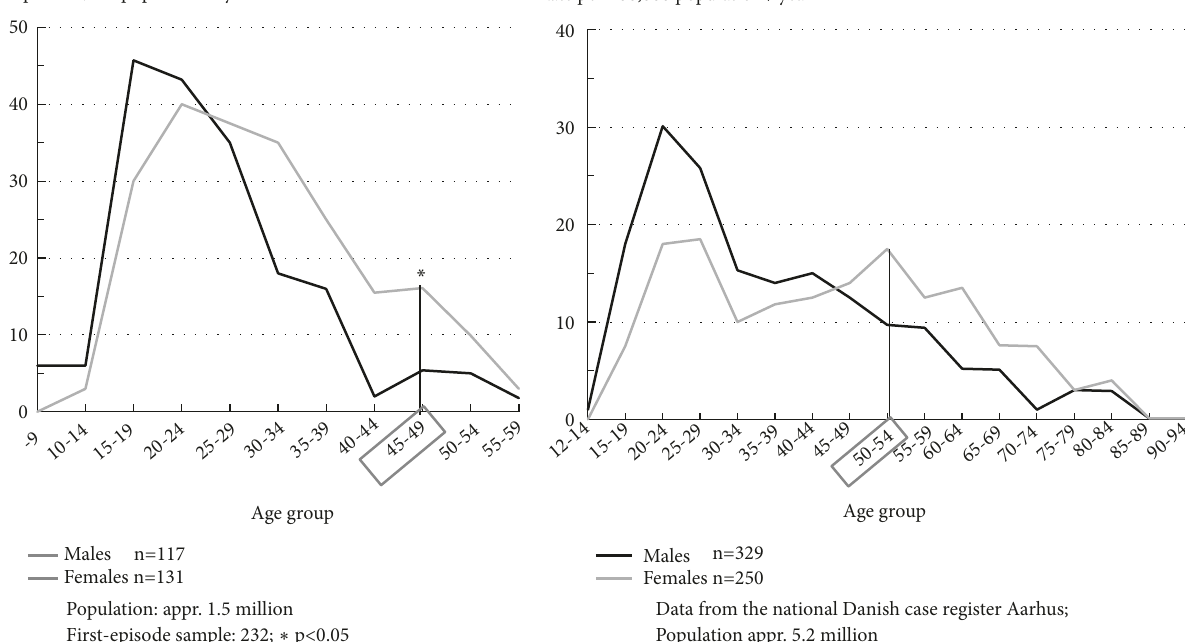
Figure 2: Left: ABC Schizophrenia Study: age at onset of schizophrenia (ICD-9: 295, 297, 298.3, 298.4) (firstpsychotic symptom) by sex; right: population-based first-admission rates for schizophrenia (ICD-8: 295) in Denmark 1976 by age and sex. Source: